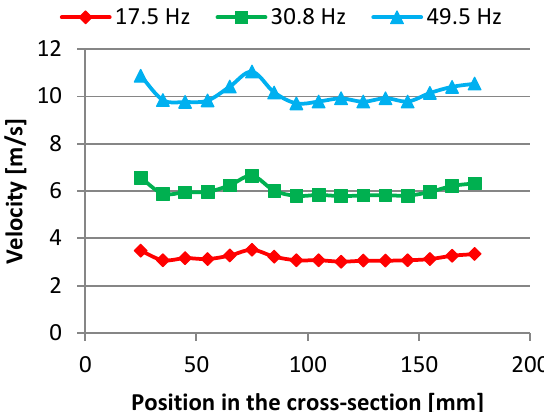
Fig. 3. Velocity profile of the test section measured in the middle of the cross-section .